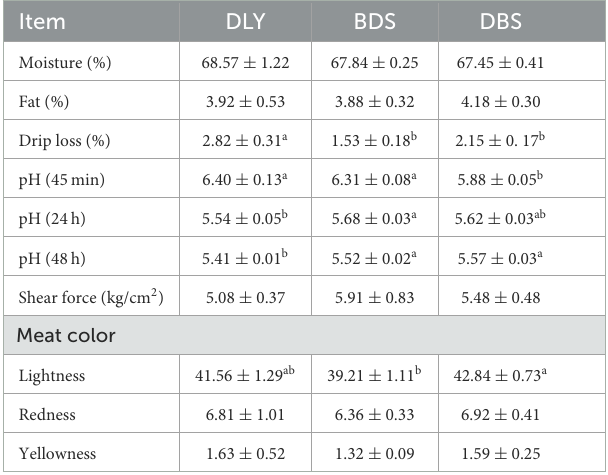
TABLE 1 Comparison of carcass characteristics among DLY, BDS, and DBS.